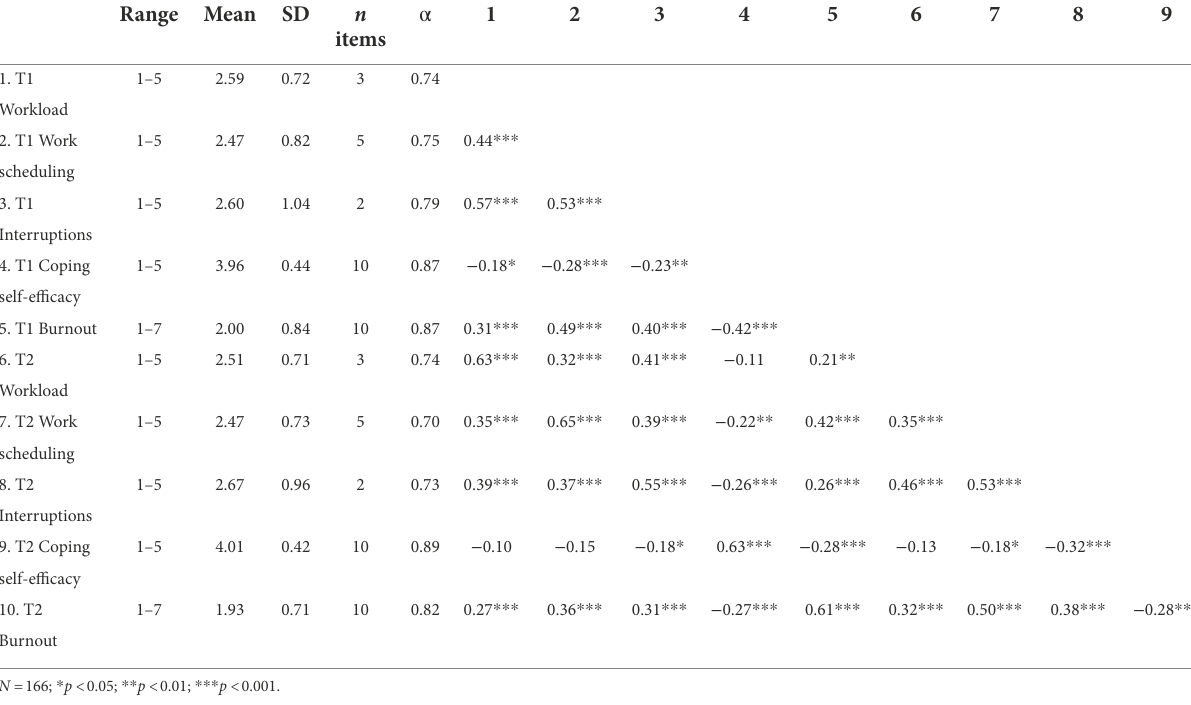
TABLE 1 Descriptive statistics Study 1 (scale, mean, standard deviation, Cronbach’s alpha, and Pearson correlations).